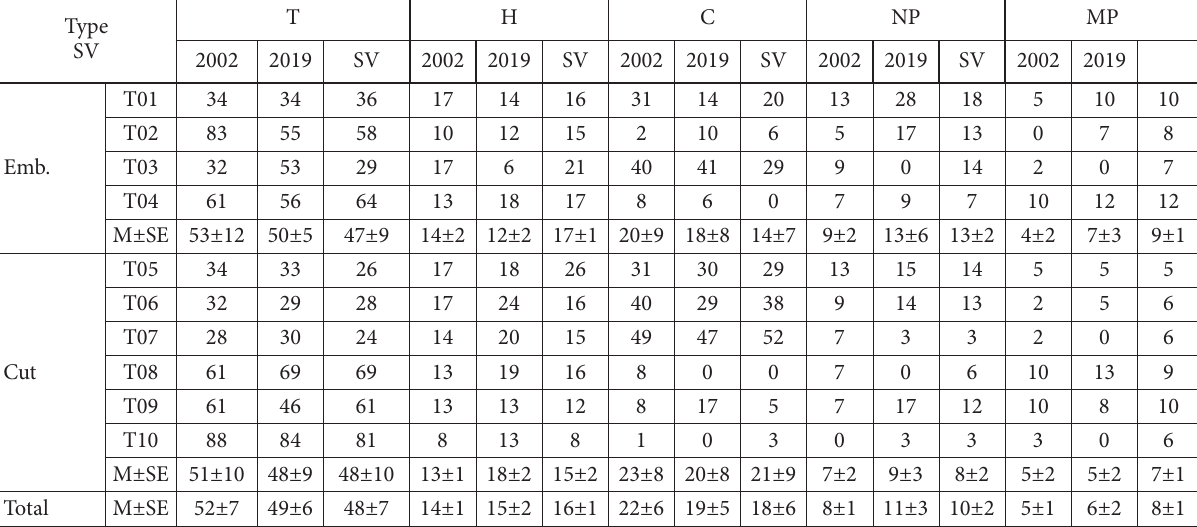
Table 5. Percentage of life-forms in surrounding vegetation and slope